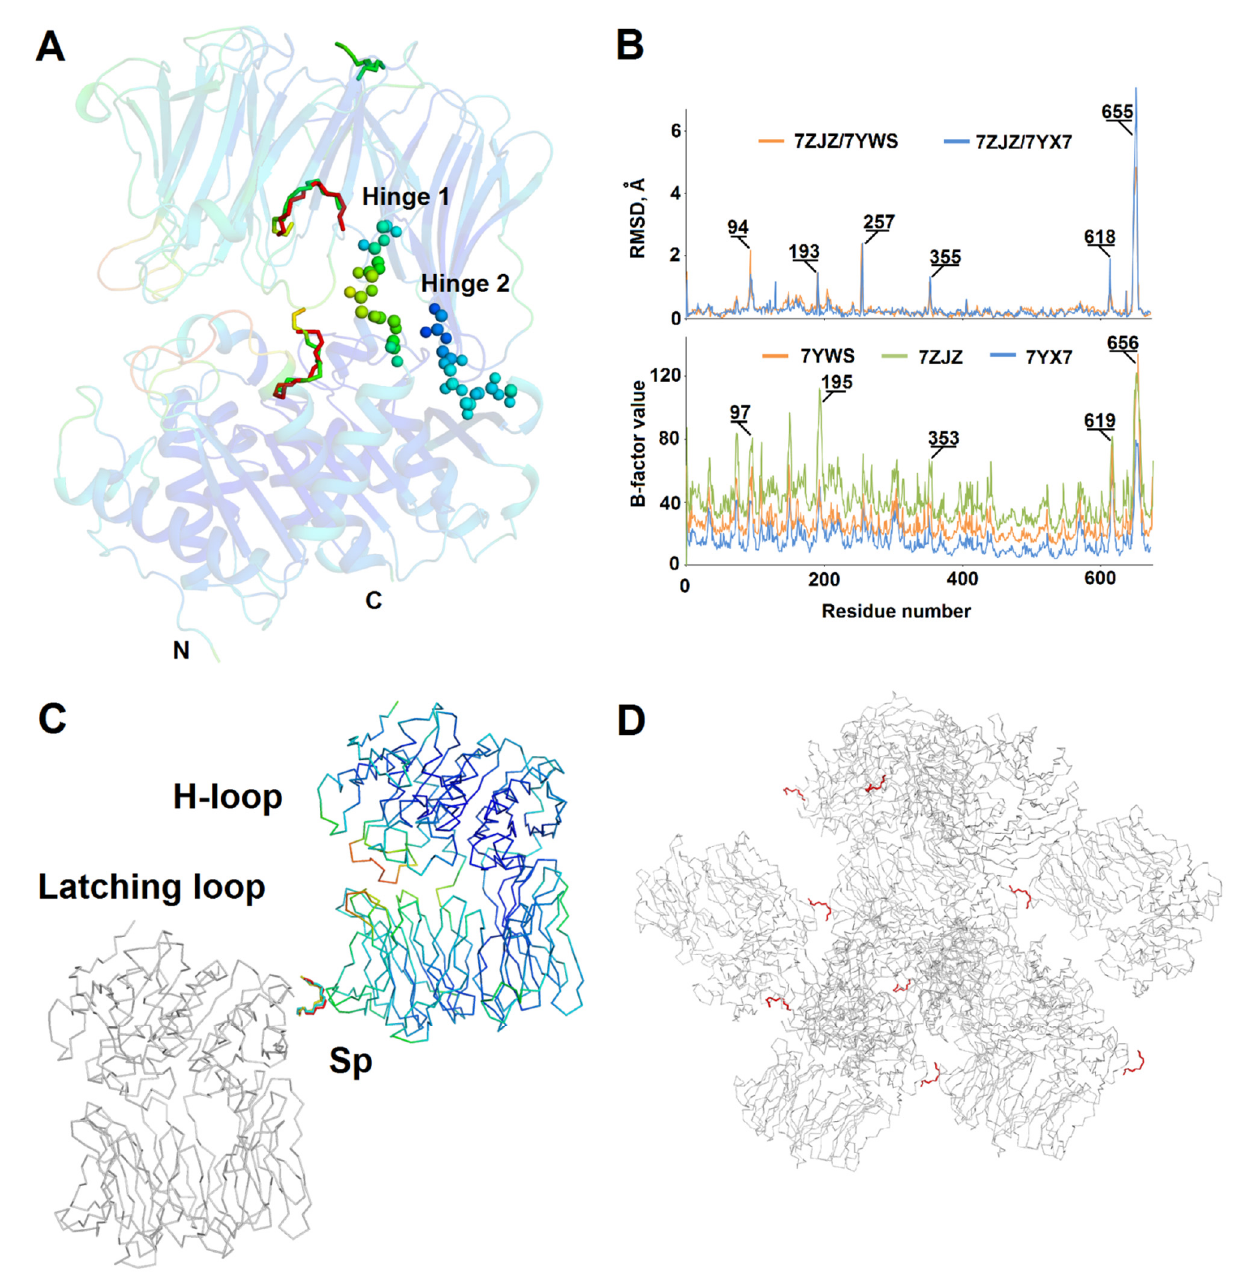
Figure 2. Comparative overview of the crystal structures obtained for enzymes with intact and modified hinge peptides. ( A ) The cartoon presentation of the SpOPBS532A structure (PDB ID 7ZJZ) colored according to the residual B-factors with spermines (shown in sticks) in the interdomain space. The aligned spermines from the SpOPBmod structure (PDB ID 7YWS) are colored in red. The main chain atoms of the hinge peptides are marked with balls. N- and C- denote N- and C-termini, respectively. ( B ) Residual RMSD values derived from C a -atom superpositions of the 7ZJZ structure over the 7YWS and 7YX7 structures and residual B-factor values obtained for all of the compared crystal structures. Residues, which have the highest RMSD and B-factors, are marked. ( C ) The conserved spermine molecule outside of the interdomain space connects the catalytic domain of one polypeptide with the β -propeller domain of another. Spermines (Sp) from 7ZJZ, 7YWS, and 7YX7 are colored by the B-factor value in red and orange, respectively. One polypeptide was colored according to the residual B-factors and the most flexible H-loop and latching loop are indicated. ( D ) Participation of spermines (red) in the crystal lattice